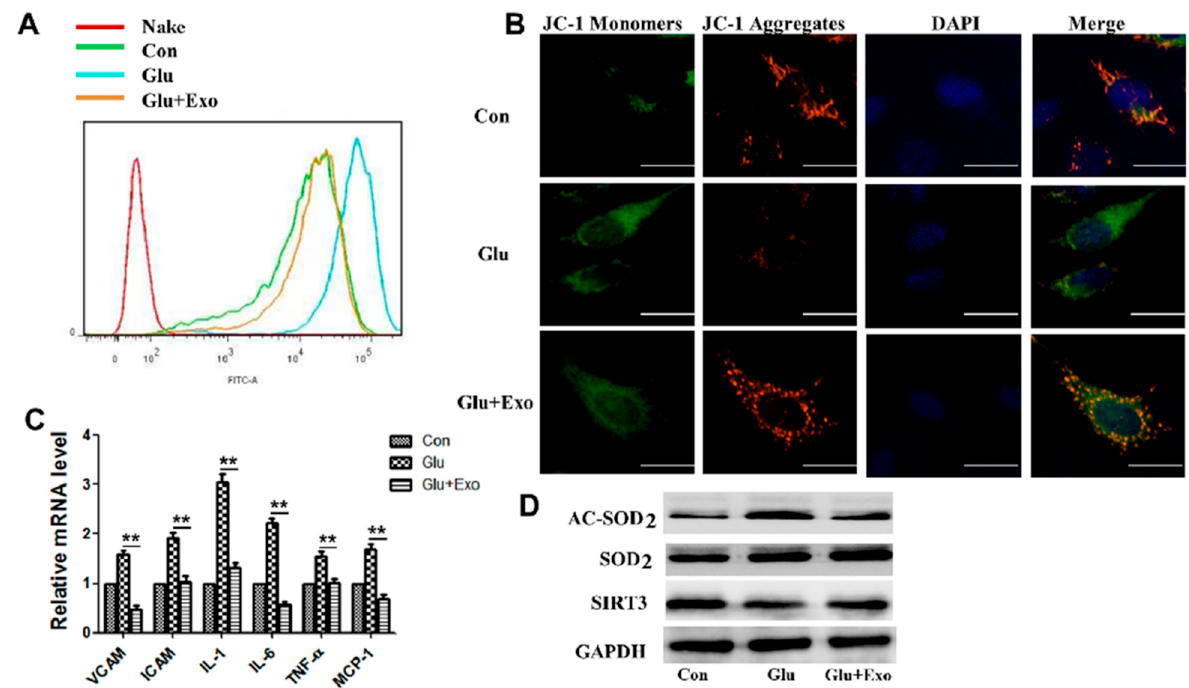
Figure 4. ADSC-exos reduce ROS production in HUVECs in a high-glucose environment, increase the MMP, reduce inflammatory cytokine levels, and promote SIRT3 expression. ( A ) Analysis of HUVECs ROS levels by flow cytometry. ( B ) JC-1 signal in HUVECs was examined by fluorescence confocal microscopy. The cells were labeled with DAPI to show the nucleus (blue) and stained with JC-1 to show the mitochondria. Double staining of cells with JC-1 is shown: green for J-monomers, red for J-aggregates (scale = 50 μ m). The data represent three independent measurements. ( C ) mRNA levels of VCAM, ICAM, IL1, IL6, TNF α , and MCP-1 in HUVECs were analyzed by qRT-PCR. ( D ) Western blot results showing the protein levels of AC-SOD2, SOD2, and SIRT3 in HUVECs treated with ADSC-exos in the high-glucose environment. The data are shown as the mean ± SD (** p < 0.01).